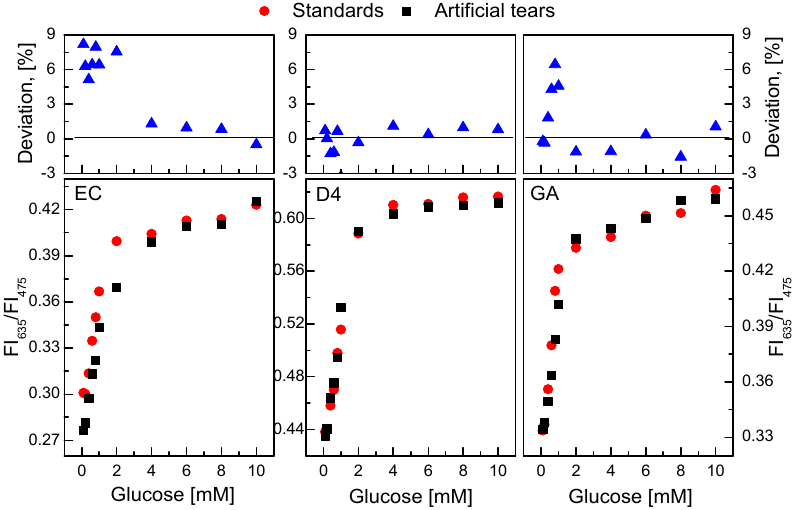
Figure 11. Response of GOD = PS@C6^PtP membranes with different supporting materials (EC, D4, and GA) to solutions of standard glucose and artificial tear glucose. Percentage deviation of ratiometric fluorescence intensities (R = FI 635 / FI 475 ) in glucose concentrations between standard solution and artificial tear represents 100 × {(R std glucose − R tear glucose ) / R std glucose }.